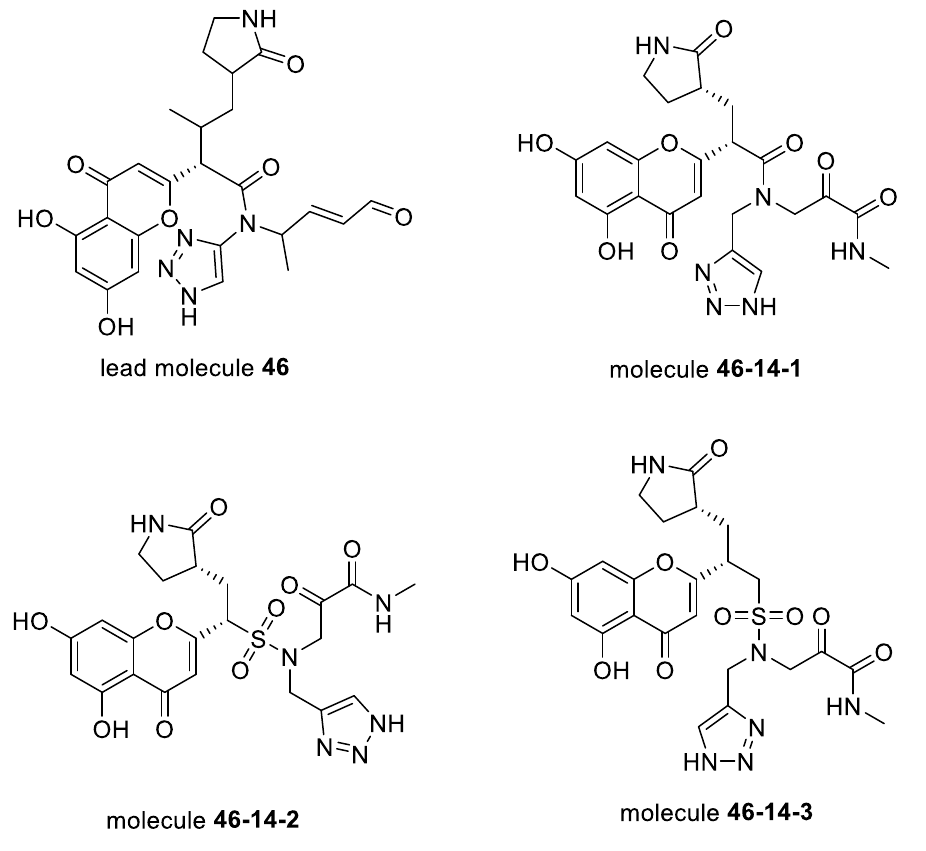
Figure 7. Structures of optimized compounds.